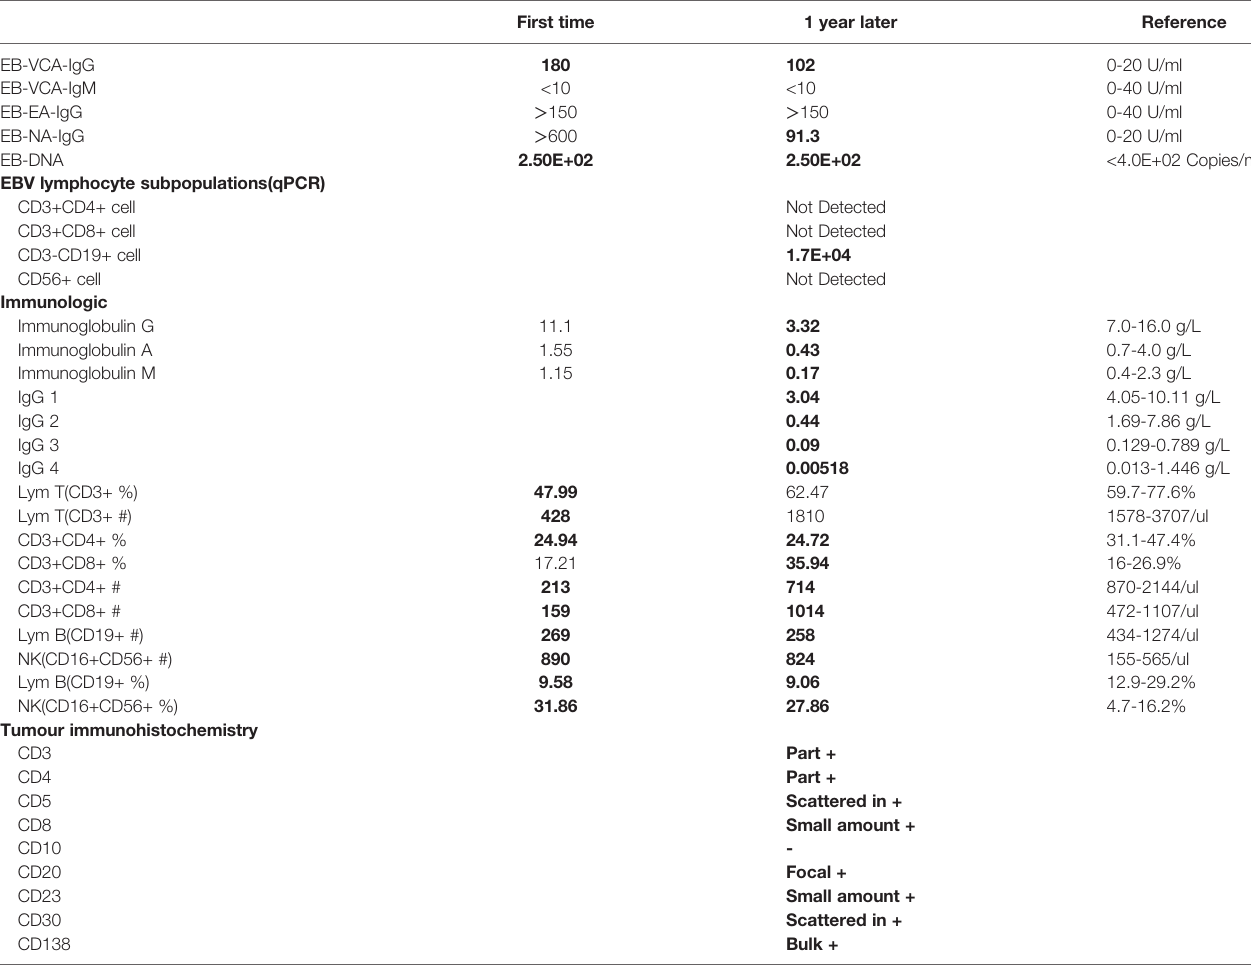
TABLE 1 | Clinical characteristics of the